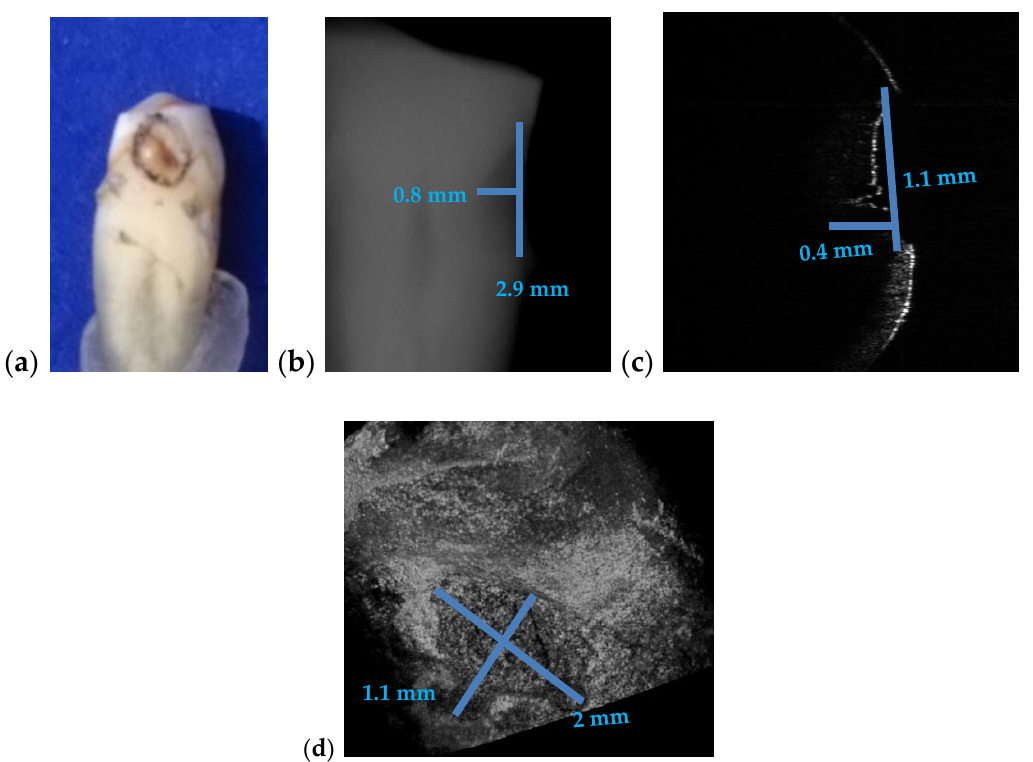
Figure 15. ( a ) A premolar tooth, with an area marked for OCT investigations; ( b ) section cropped from an intraoral radiograph with a view on the measured dental cavity; ( c ) OCT B-scan, where the depth and the width of the cavity are measured; ( d ) volumetric OCT reconstruction, on which the width and the length are measured.